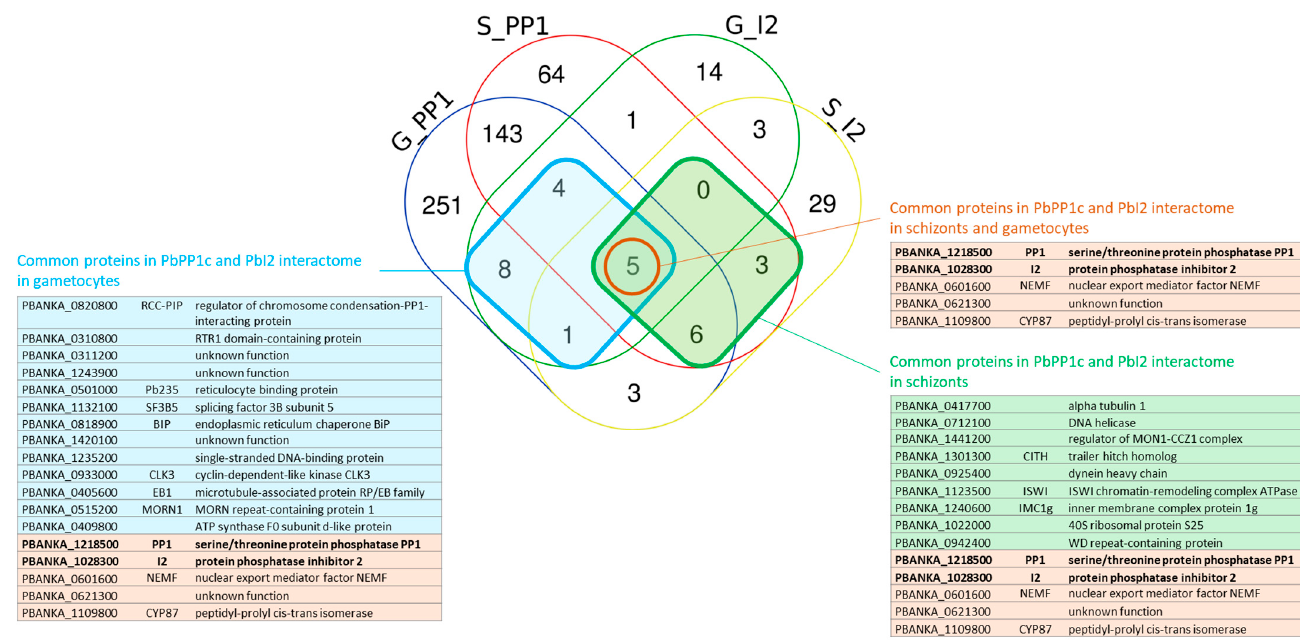
Figure 6. Distribution analysis of the PbPP1c and PbI2 potential partners identified in IP/MS in P. berghei schizonts and gametocytes. The Venn diagram shows the number of PbPP1c and PbI2 partners identified in schizonts (S_PP1 and S_I2, respectively) and gametocytes (G_PP1 and G_I2, respectively). Common proteins in the PbPP1c and PbI2 interactomes in schizonts or in gametocytes are boxed in green and blue squares, respectively, and listed in adjacent tables showing the PlasmoDB geneID, short name, and protein description with the same color code. Common proteins in PbPP1c and PbI2 interactomes in schizonts and gametocytes are circled and listed in orange. This diagram was created using the Venn online tool https://bioinformatics.psb.ugent.be/webtools/Venn/ accessed on 4 May 2021.